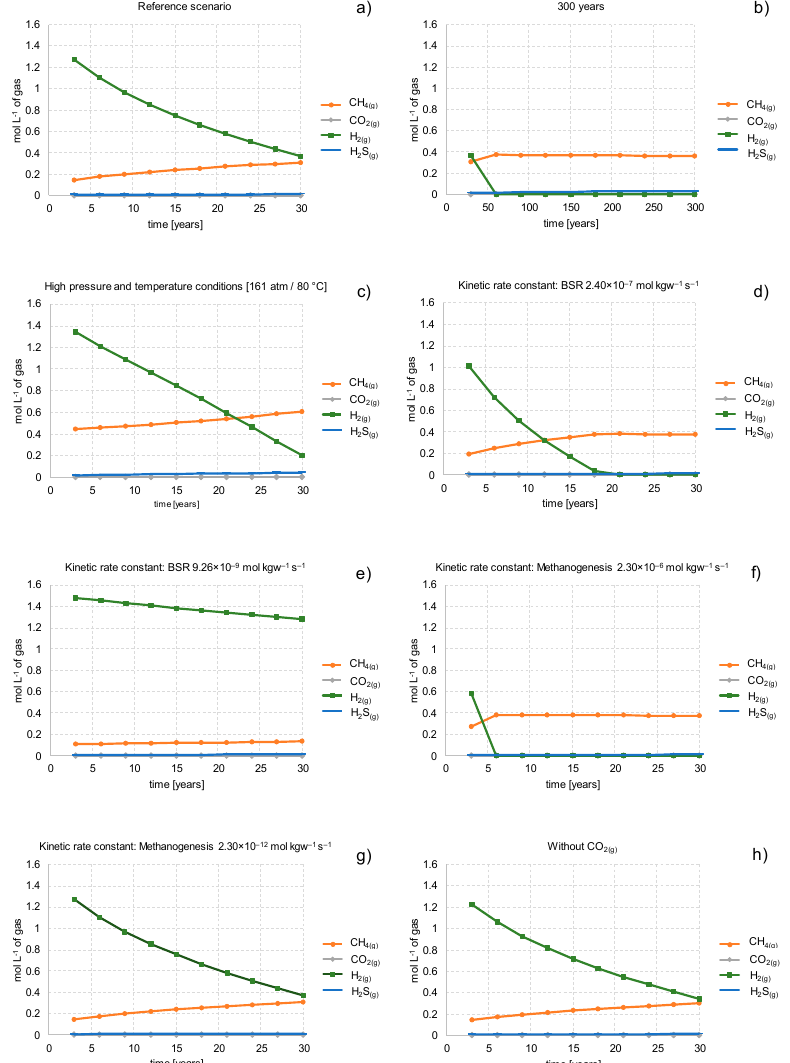
00.20.40.60.811.21.41.6 Figure 2. Changes in gas composition in the reservoir rock with ongoing time in ( a ) reference scenario and influenced by ( b ) increased storage time of 300 years, ( c ) higher pressure and temperature conditions, ( d ) higher kinetic rate constant for BSR of 2.40 × 10 − 7 mol kgw − 1 s − 1 , ( e ) lower kinetic rate constant for BSR of 9.26 × 10 − 9 mol kgw − 1 s − 1 , ( f ) higher kinetic rate constant for methanogenesis of 2.30 × 10 − 6 mol kgw − 1 s − 1 , ( g ) lower kinetic rate constant for methanogenesis of 2.30 × 10 − 12 mol kgw − 1 s − 1 , ( h ) varied stored gas composition (without CO 2(g) ).